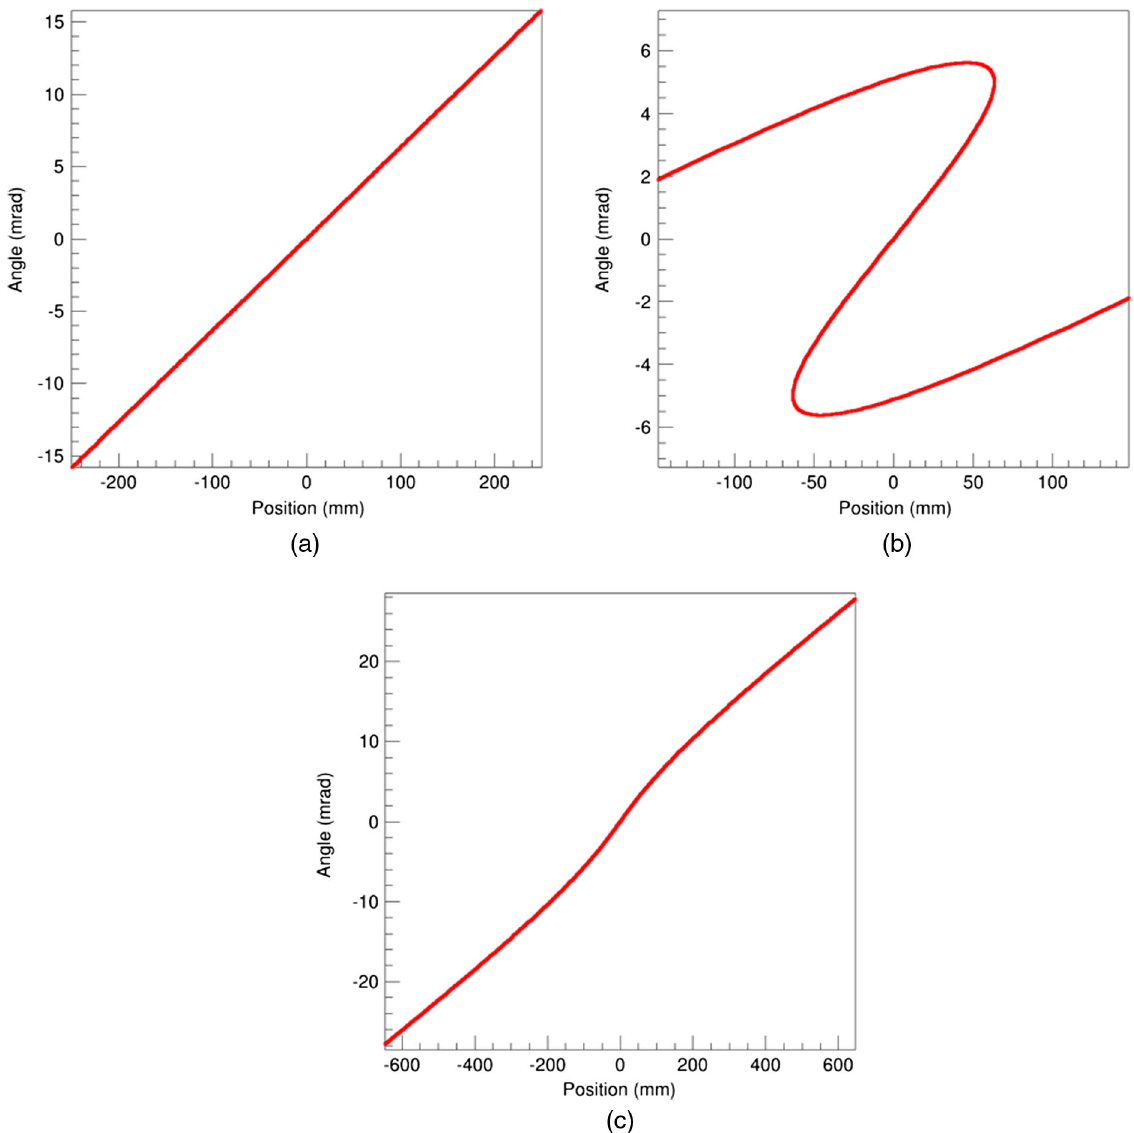
FIG. 21. Phase space distribution expressed by filament model for (a) linear optics, (b) nonlinear optics for focusing, and (c) nonlinear optics for